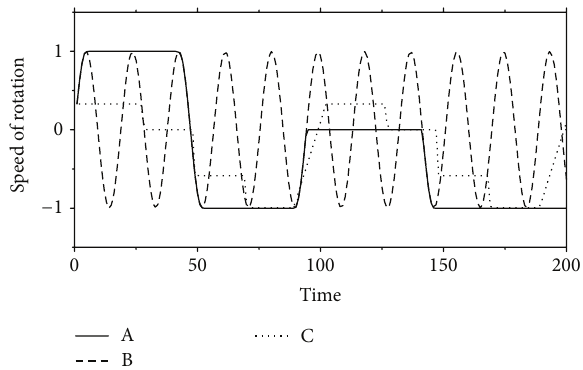
Figure 2: Examples of the generated patterns of an oscillator. (A) Simple rotation: the full speed to clockwise at 𝑡 [0, 50] and to anticlockwise at 𝑡 [50, 100] ; (B) repeating the motion of a module in a sine wave; (C) a module repeating some